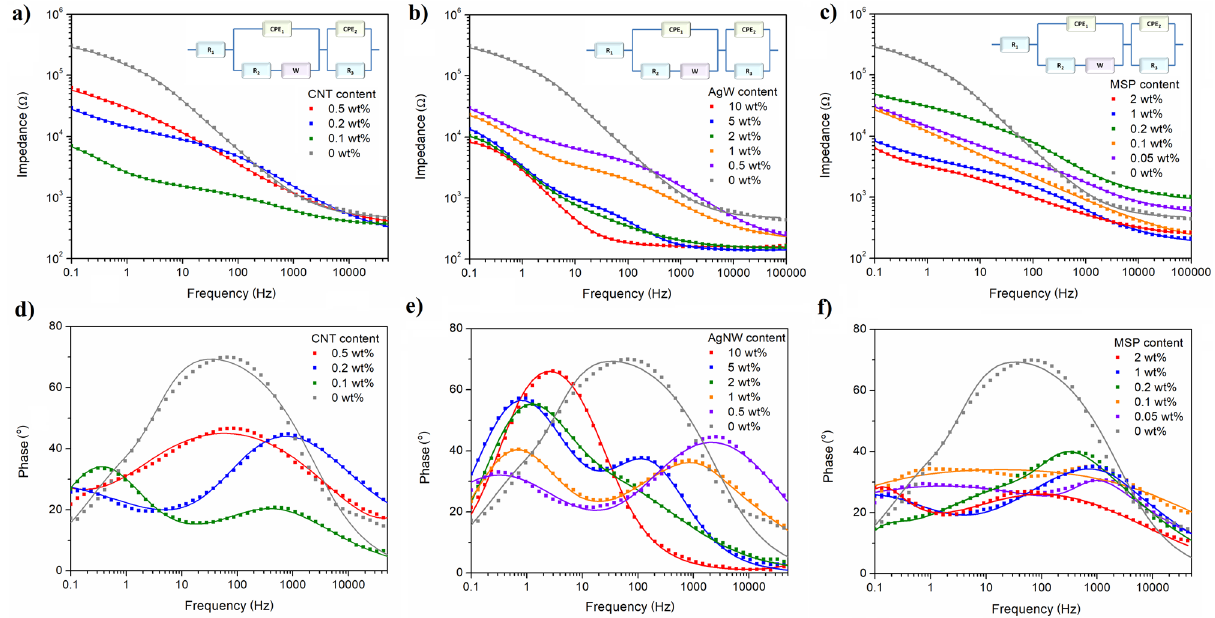
Figure 2. Electrochemical impedance spectroscopy study of EDL-based composites. Bode plots showing the frequency-dependent behaviour of the impedance modulus of EDL/CNT ( a ), EDL/AgNW ( b ) and EDL/ MSP ( c ), and phase angle of EDL/CNT ( d ), EDL/AgNW ( e ) and EDL/MSP ( f ) composites; dots represent experimental data, while lines represent simulated results; equivalent circuit models used for the fitting of EIS data are presented as the insets. EIS data were collected in 0.1 M KCl solution, in the frequency range from 0.1 Hz to 100 kHz, with an AC amplitude of 40 mV (vs. Ag/AgCl) and a DC potential equal to 0 V (vs. Ag/ AgCl). EIS simulations were performed by means of EIS Spectrum Analyzer 1.0 software (http://www.abc.chemi stry.bsu.by/vi/analy ser/).